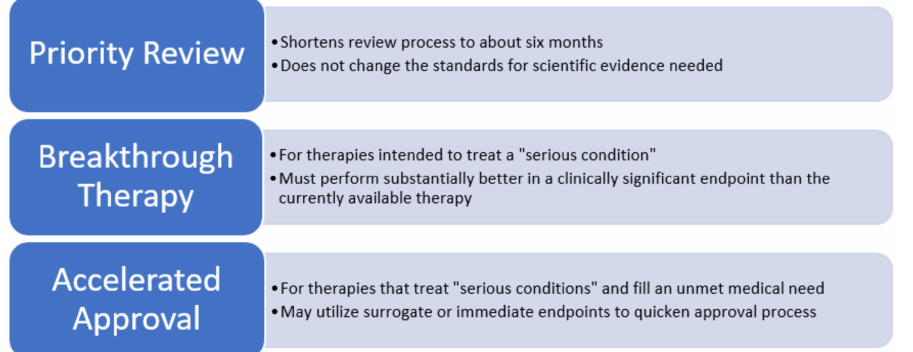
Figure 2. FDA’s Rapid Approval Processes of Priority Review, Breakthrough Therapy, and